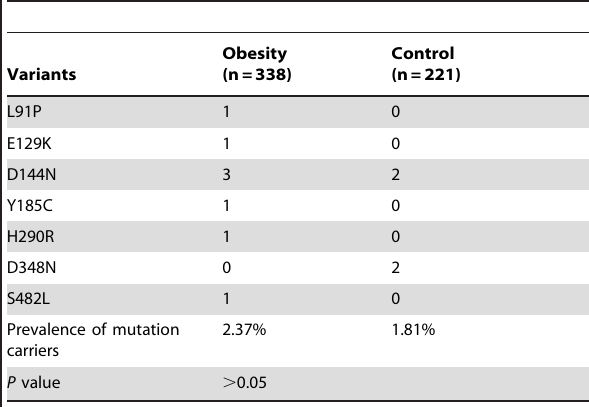
Sanger Sequencing We screened the exonic and flanking regions of the FTO and SH2B1 by Sanger sequencing. PCR primers (Table S1 & S2) were designed with Primer3 tool (http: //frodo.wi.mit.edu/primer3/) to contain exonic sequences and their flanking regions of 20 bp. PCR amplifications were inspected for single band of expected sizes on agarose gels before purification with Agencourt AMPure on Biomek NX (Beckman Coulter, USA). Sequencing was achieved using the automated ABI Prism 3730xlDNA Sequencer in combination with the Big Dye Terminator Cycle Sequencing